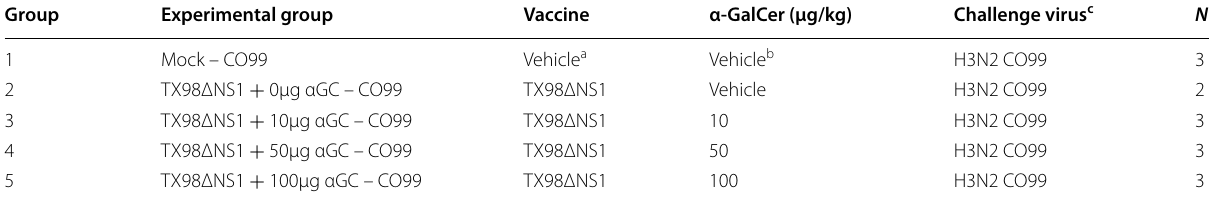
Table 1 Experiment 1 setup